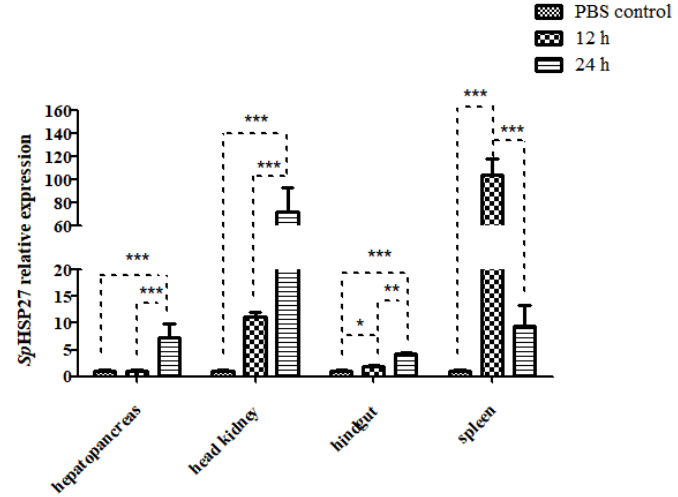
Figure 6. Transcript levels of Sp HSP27 at different times after LPS challenge. Each value represents a mean ± SD ( n = 4 fish per group); statistical significance was decided using one-way ANOVA followed by Tukey tests. Note: an asterisk (*) over a column represents a statistically significant difference, one for p < 0.05, two for <0.01 and three for <0.001.